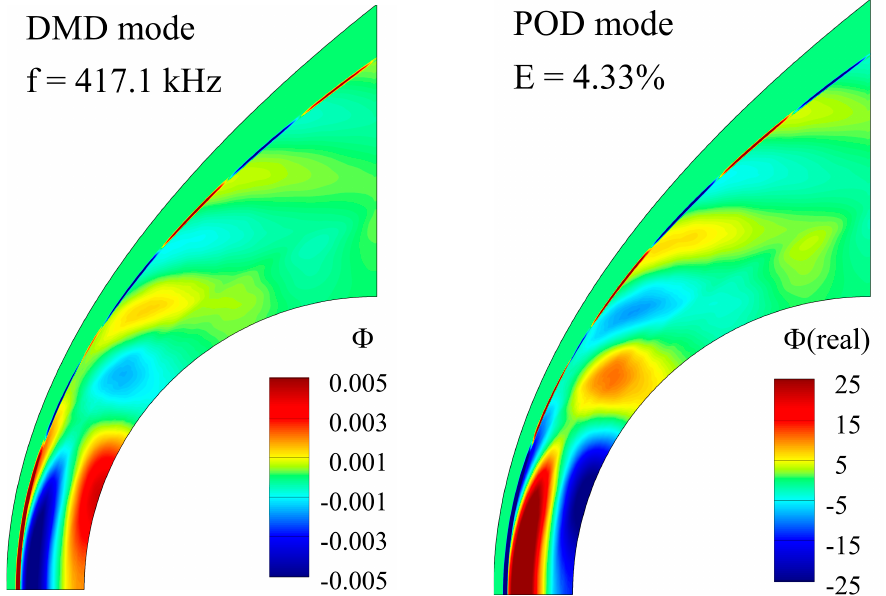
Figure 19. Dominant spatial coherent structures extracted from DMD and POD analysis.